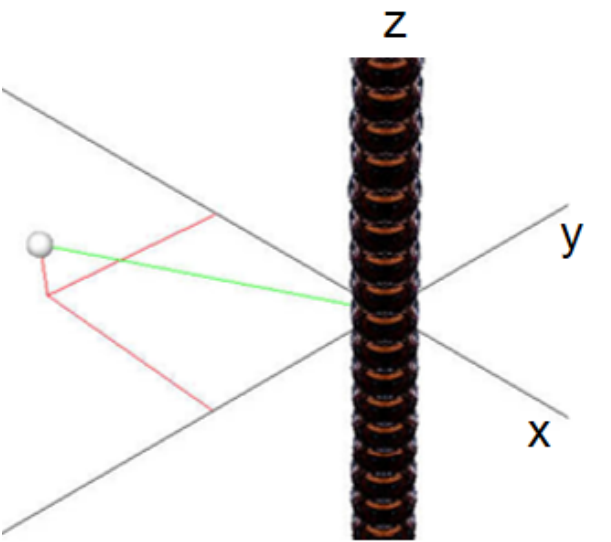
Figure 9. Interface elements of the “line charge” visuo-haptic environment developed with Chai